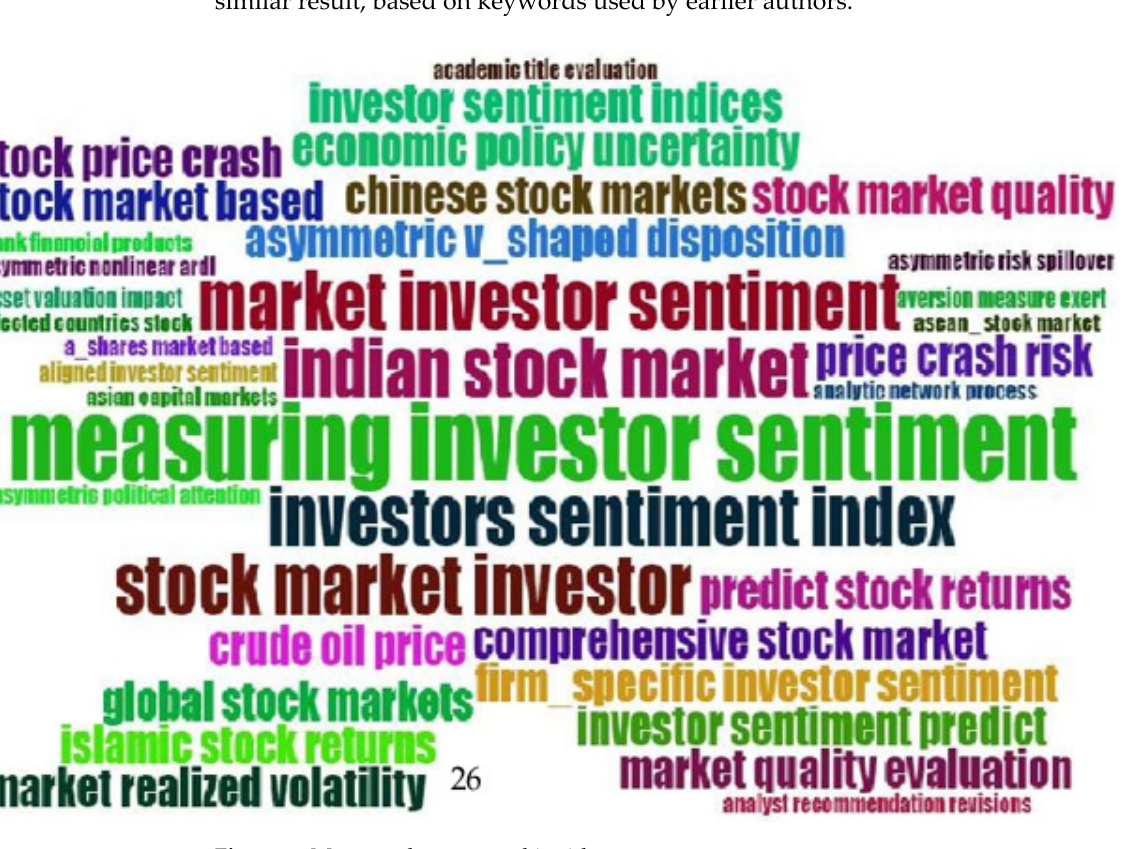
Figure 10. Mapping based on the keywords used by authors.